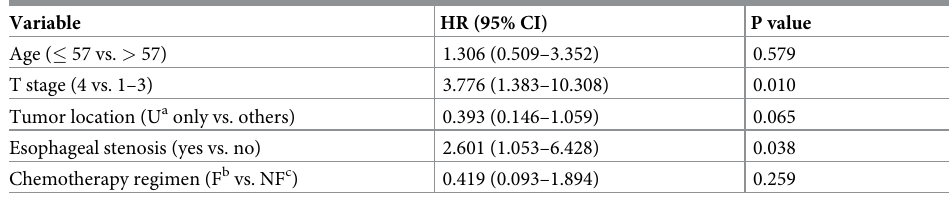
Table 3. Multivariate analysis of clinical variables associated with esophageal fistula.